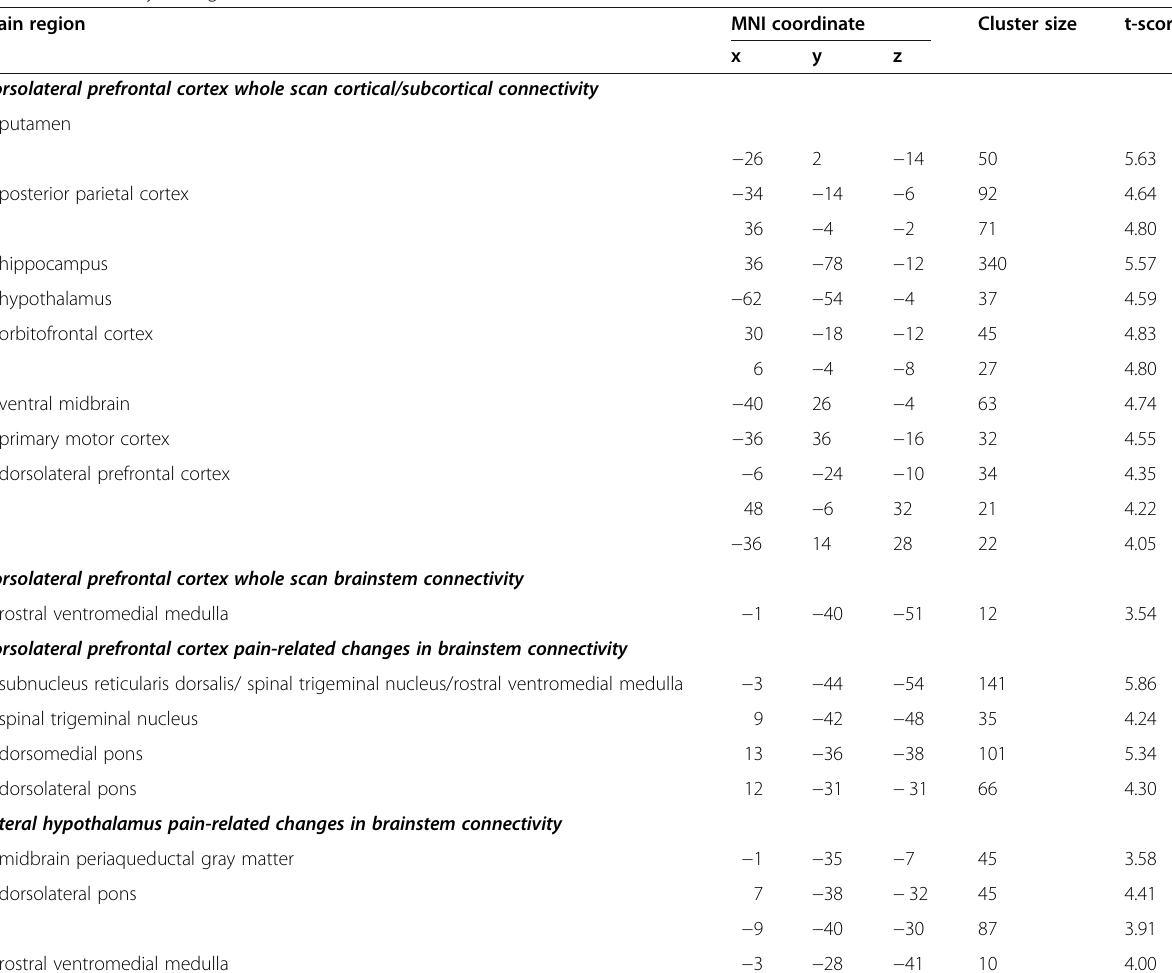
Table 3 Montreal Neurological Institute (MNI) coordinates, cluster size and t-score for regions with reduced whole scan and pain- related connectivity changes Brain